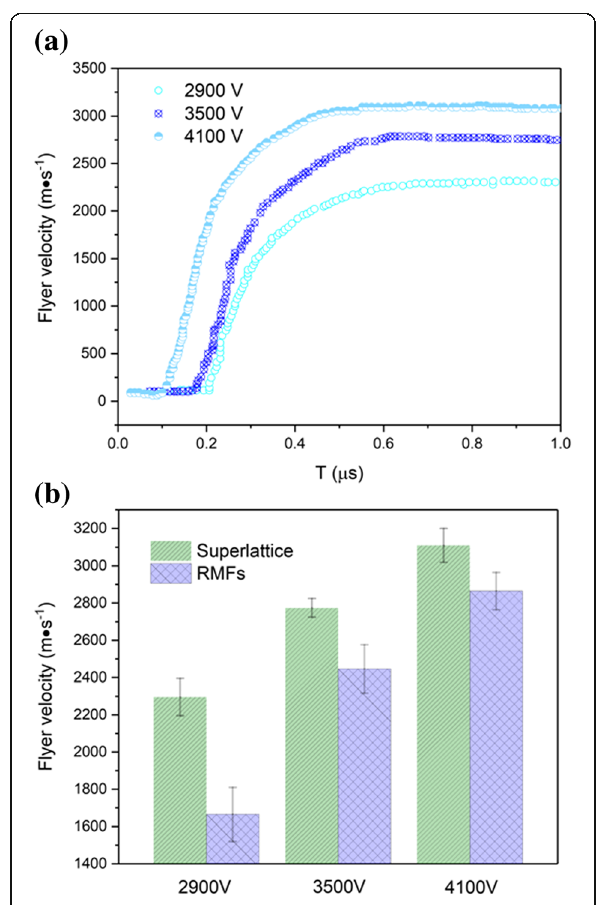
Fig. 6 a Flyer velocity curves for different capacitor charging voltage levels applied to energetic Al/Ni superlattice. b Flyer velocity for the energetic Al/Ni superlattice and Al/Ni RMFs with charging voltages ranging from 2900 to 4100